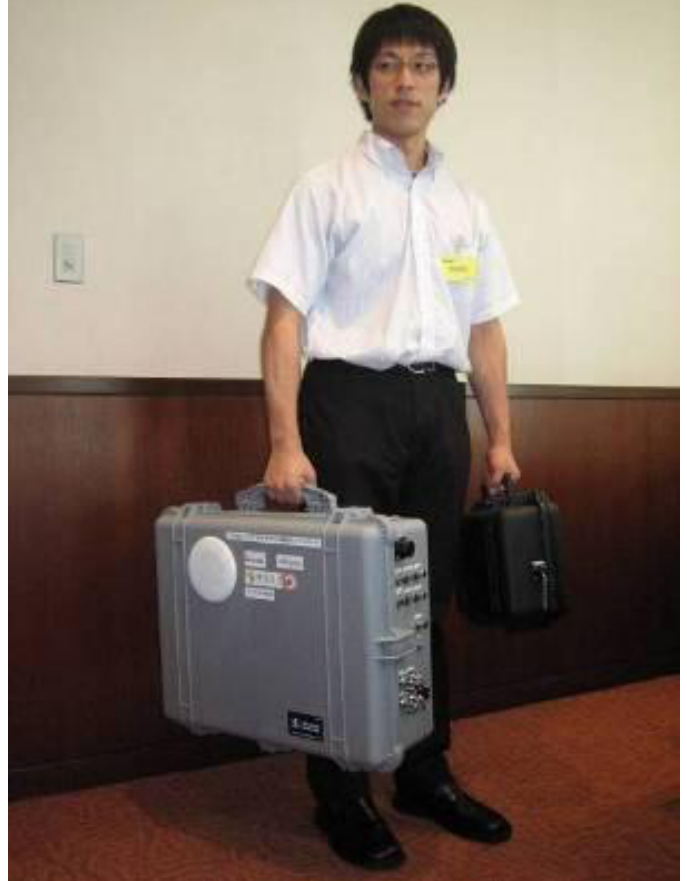
Figure 12. Our system’s main unit (gray box) and battery unit (black box).